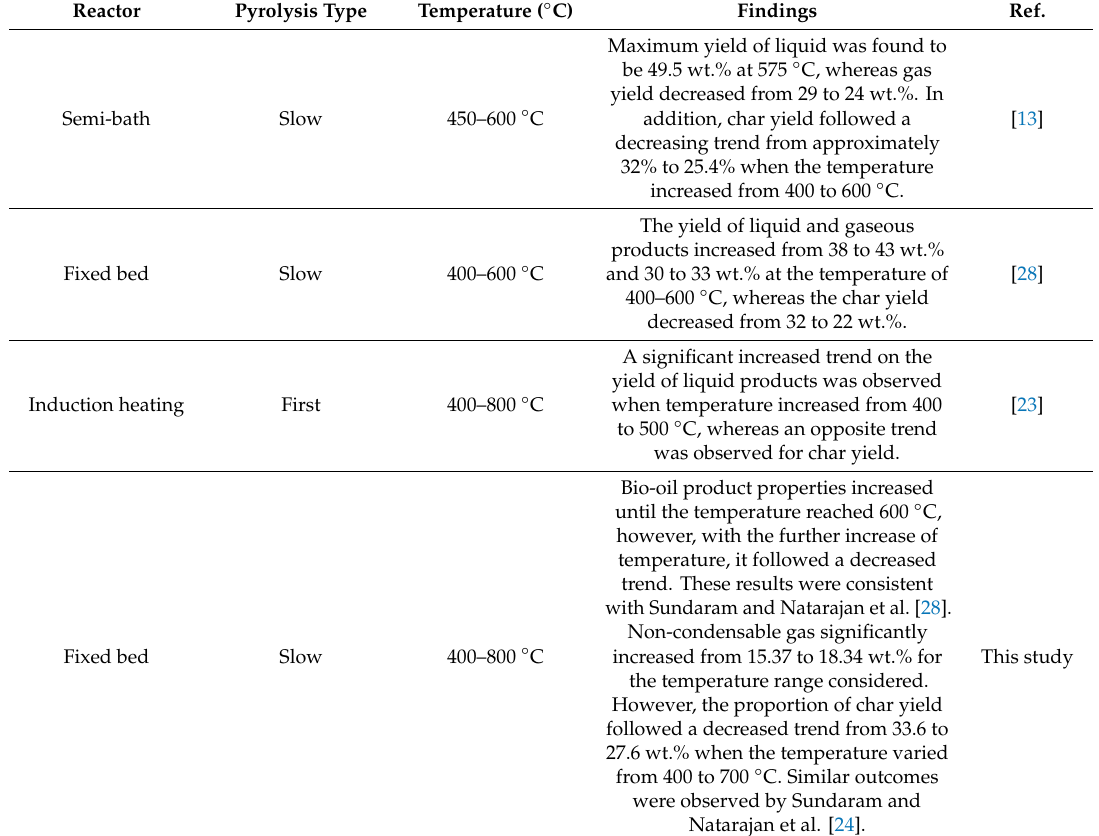
Figure 2. Product yields of pyrolysis products against varying conditions of temperature, where each bar indicates the mean ± standard error [ SE ( n = 3 )]. Note: distinct letters in each specific yield bar indicate significant differences ( p ≤ 0.05). Table 3. Comparison of pyrolysis product yield of coconut shell.